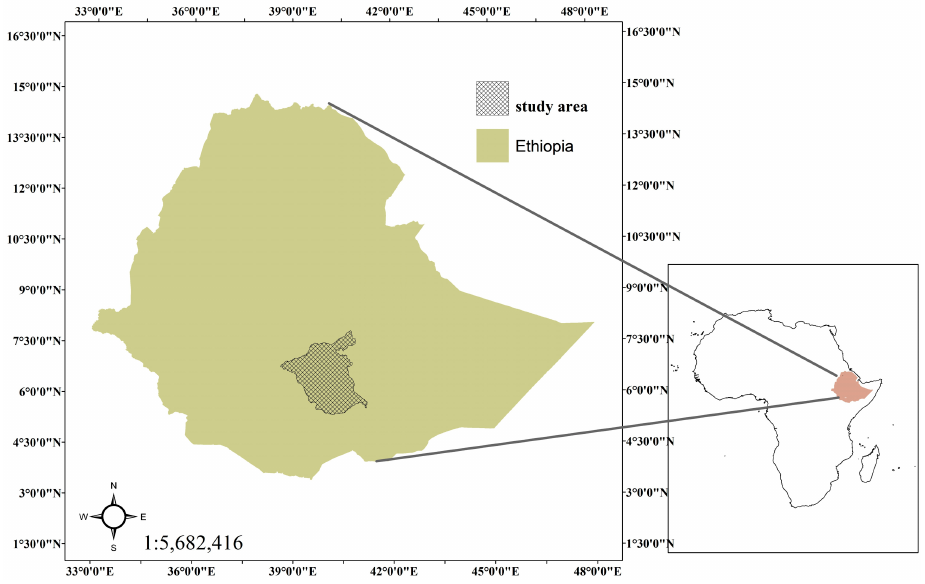
Figure 1. Map of Ethiopia showing the location of the study area.